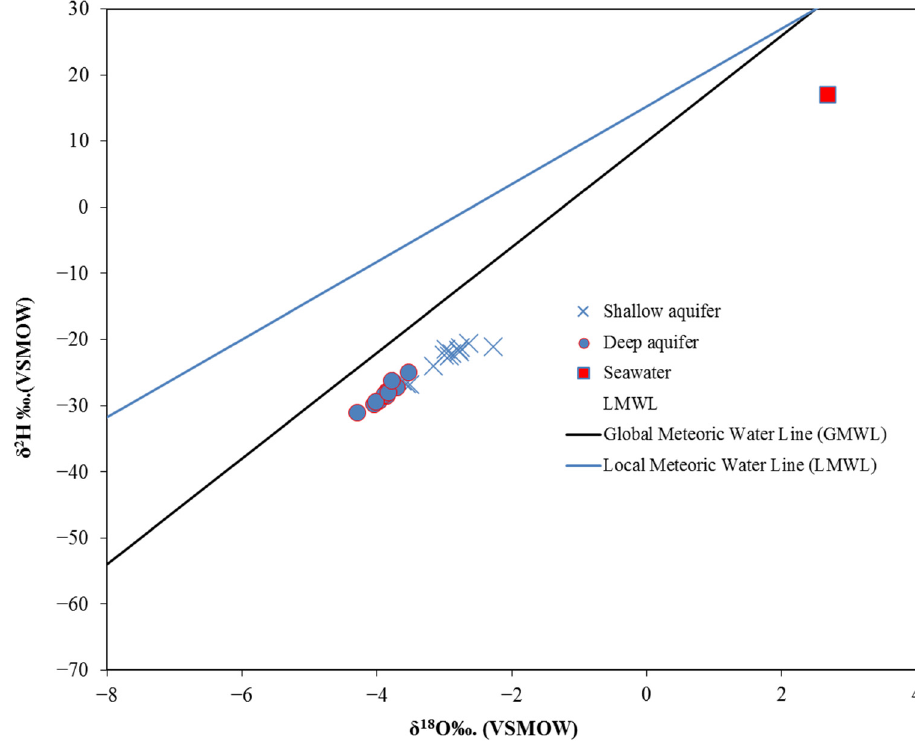
Figure 16. Plot of δ 18 O versus δ 2 H showing stable isotope variation of analyzed GW samples.